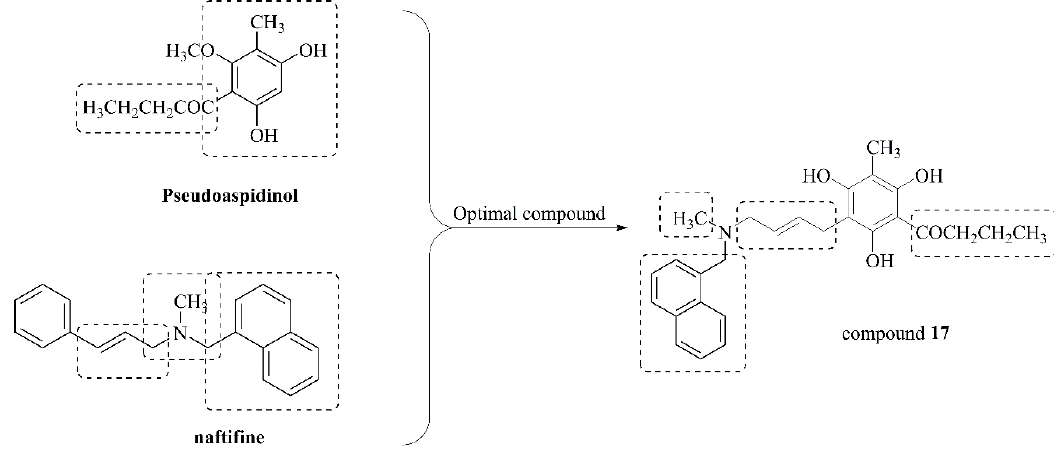
Figure 1. Design of